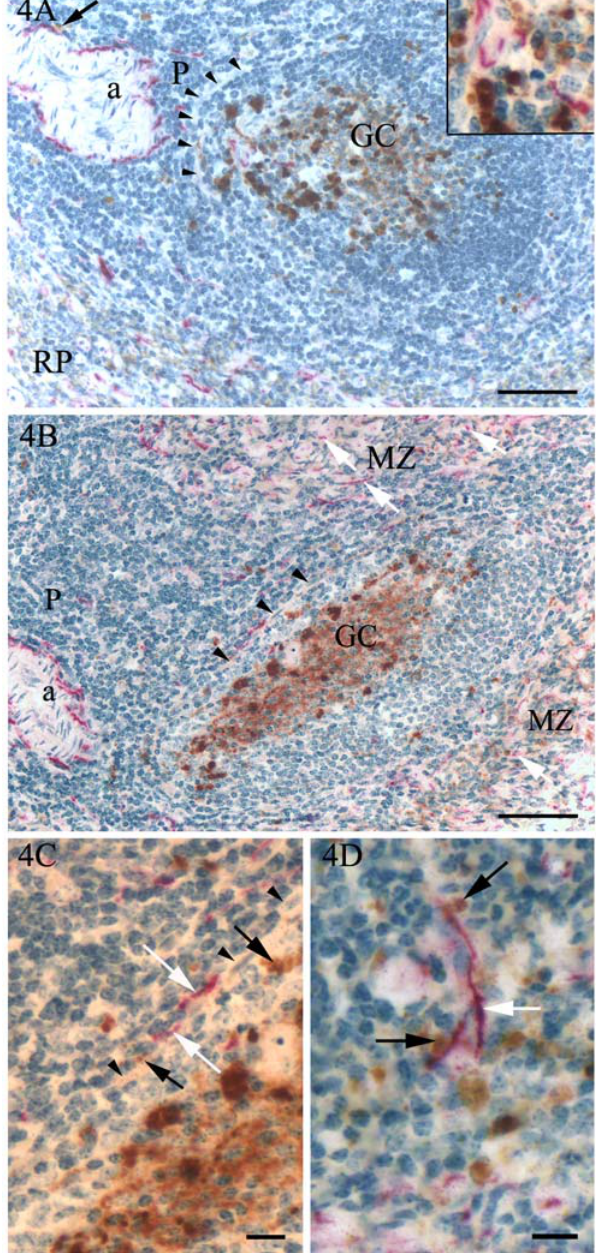
Figure 4. Immunohistochemistry, double labelling for PrP Sc ( browncolour ) and nerves ( PGP,redcolour ). Scrapie inoculated sheep. A, B. In the germinal centres (GC), a few nerve fibres were present in close association with cells strongly immunolabelled for PrP Sc (A; inset). In some areas, the lymphoid nodules were separated from the PALS by a narrow rim of spindle-shaped cells (A, B; arrowheads) with PrP Sc labelling mostly confined to the nodule side of the rim. In the PALS, nerves were most abundant around the arteriole (a), sometimes with PrP Sc -labelled granules close to the nerve fibres (A; arrow). Among the lymphoid cells of the PALS, a few nerve fibres and small granules labelled for PrP Sc were generally not co-localised. In the red pulp (A; RP) and the marginal zone (B; MZ), longitudinallyand cross-sectionedsmall nerve fibres (B; whitearrows)were abundant. C. High power view of B, showing the PALS-germinal centre transition (arrowheads), PGP labelled nerve fibres (white arrows) and PrP Sc (black arrows). D. In the marginal zone, the nerve fibres (white arrow) were often close to numerous small granules labelled for PrP Sc (black arrows). Bars, 100 m m (A, B), 10 m m (C, D). Nuclei were stained with haematoxylin.